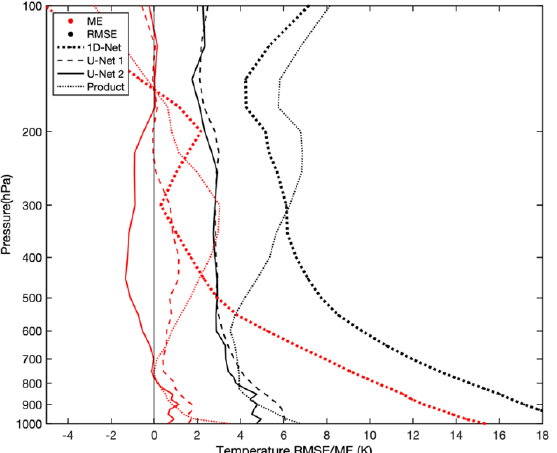
Figure 10. Temperature retrieval error profiles compared with ERA5 reanalysis field for the whole February 2021. The red lines are ME profiles, the black lines are RMSE profiles. The thicker dash ‐ dotted line represents the 1D ‐ Net scheme, the dashed line is the U ‐ Net 1 scheme, the solid line is the U ‐ Net 2 scheme, and the thinner dash ‐ dotted line represents the L2 operational products.